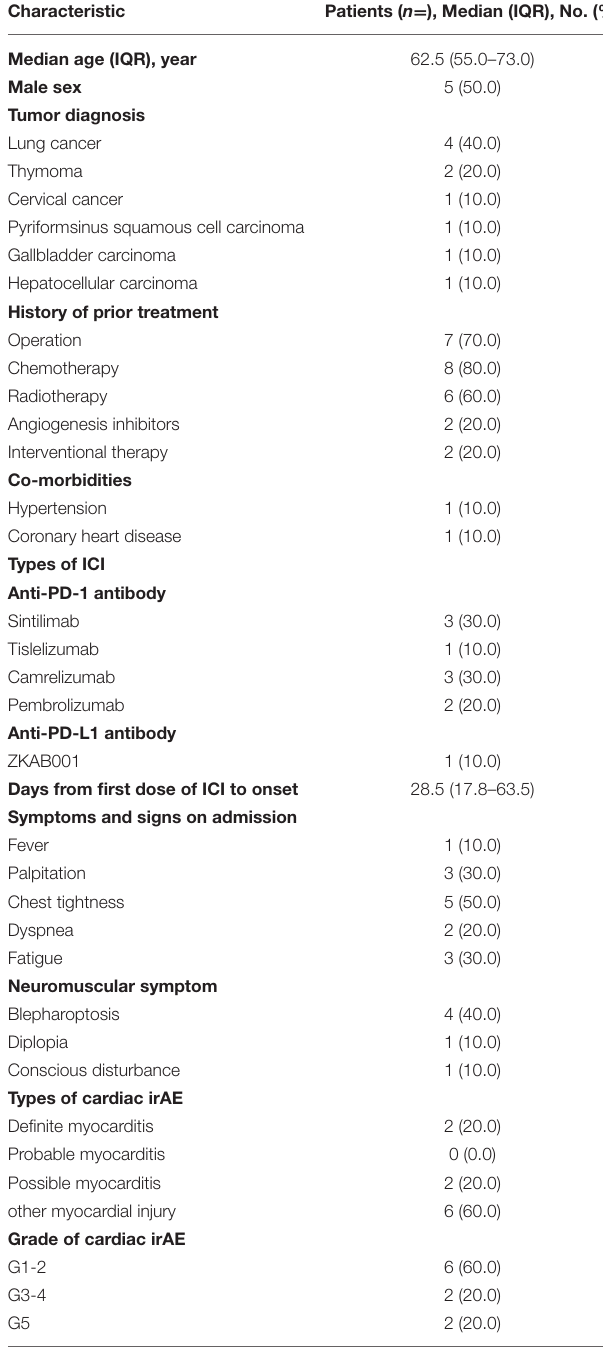
TABLE 1 | Demographic and base line clinical characteristics of the patients with cardiac irAE.